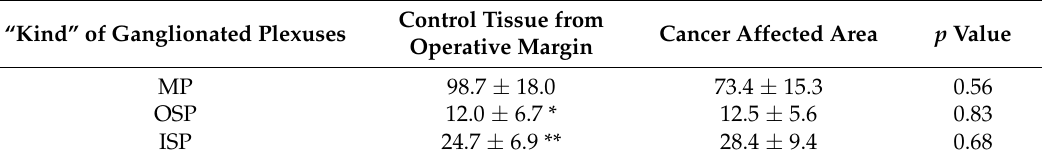
Table 1. The total number of protein gene product (PGP) 9.5-containing neurons in the myenteric plexus (MP), outer submucosal plexus (OSP), and inner submucosal plexus (ISP) in control and cancer-affected areas of the human colonic wall. Data are presented as means ± SEM. Control Tissue from Operative Margin “Kind” of Ganglionated Plexuses Cancer Affected